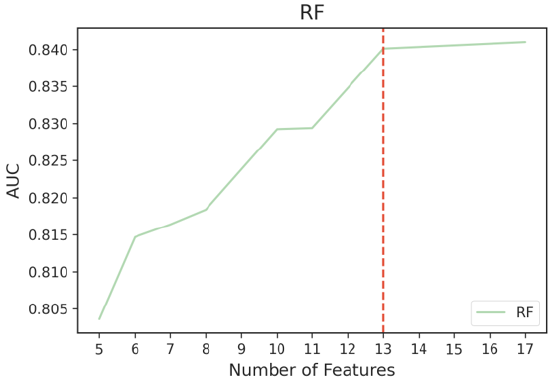
Figure 13. Cutoff point for RF, where performance tapers off when adding more MRMR features.